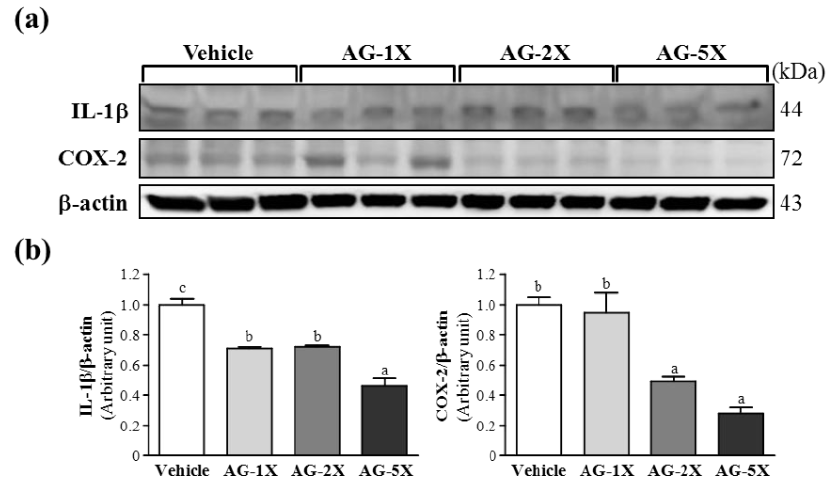
Figure 4. Effect of AG supplementation on ethanol-induced expression of inflammatory proteins in rat stomachs. Rats were pretreated with 0 (Vehicle), 250 (AG-1X), 500 (AG-2X) and 1250 (AG-5X) mg/kg AG for 1 h before a single oral administration of ethanol (70%, 10 mL/kg). At 4 h after ethanol administration, animals were killed and stomachs were collected. ( a )Western blot analysis and quantification of protein levels of IL-1 β and COX-2; and ( b ) Densitometry analysis was performed to quantify the expression levels of detected proteins. Data are mean ± SEM (n = 8 mice per group). Different letters (a, b, c) indicate a significant difference at p <